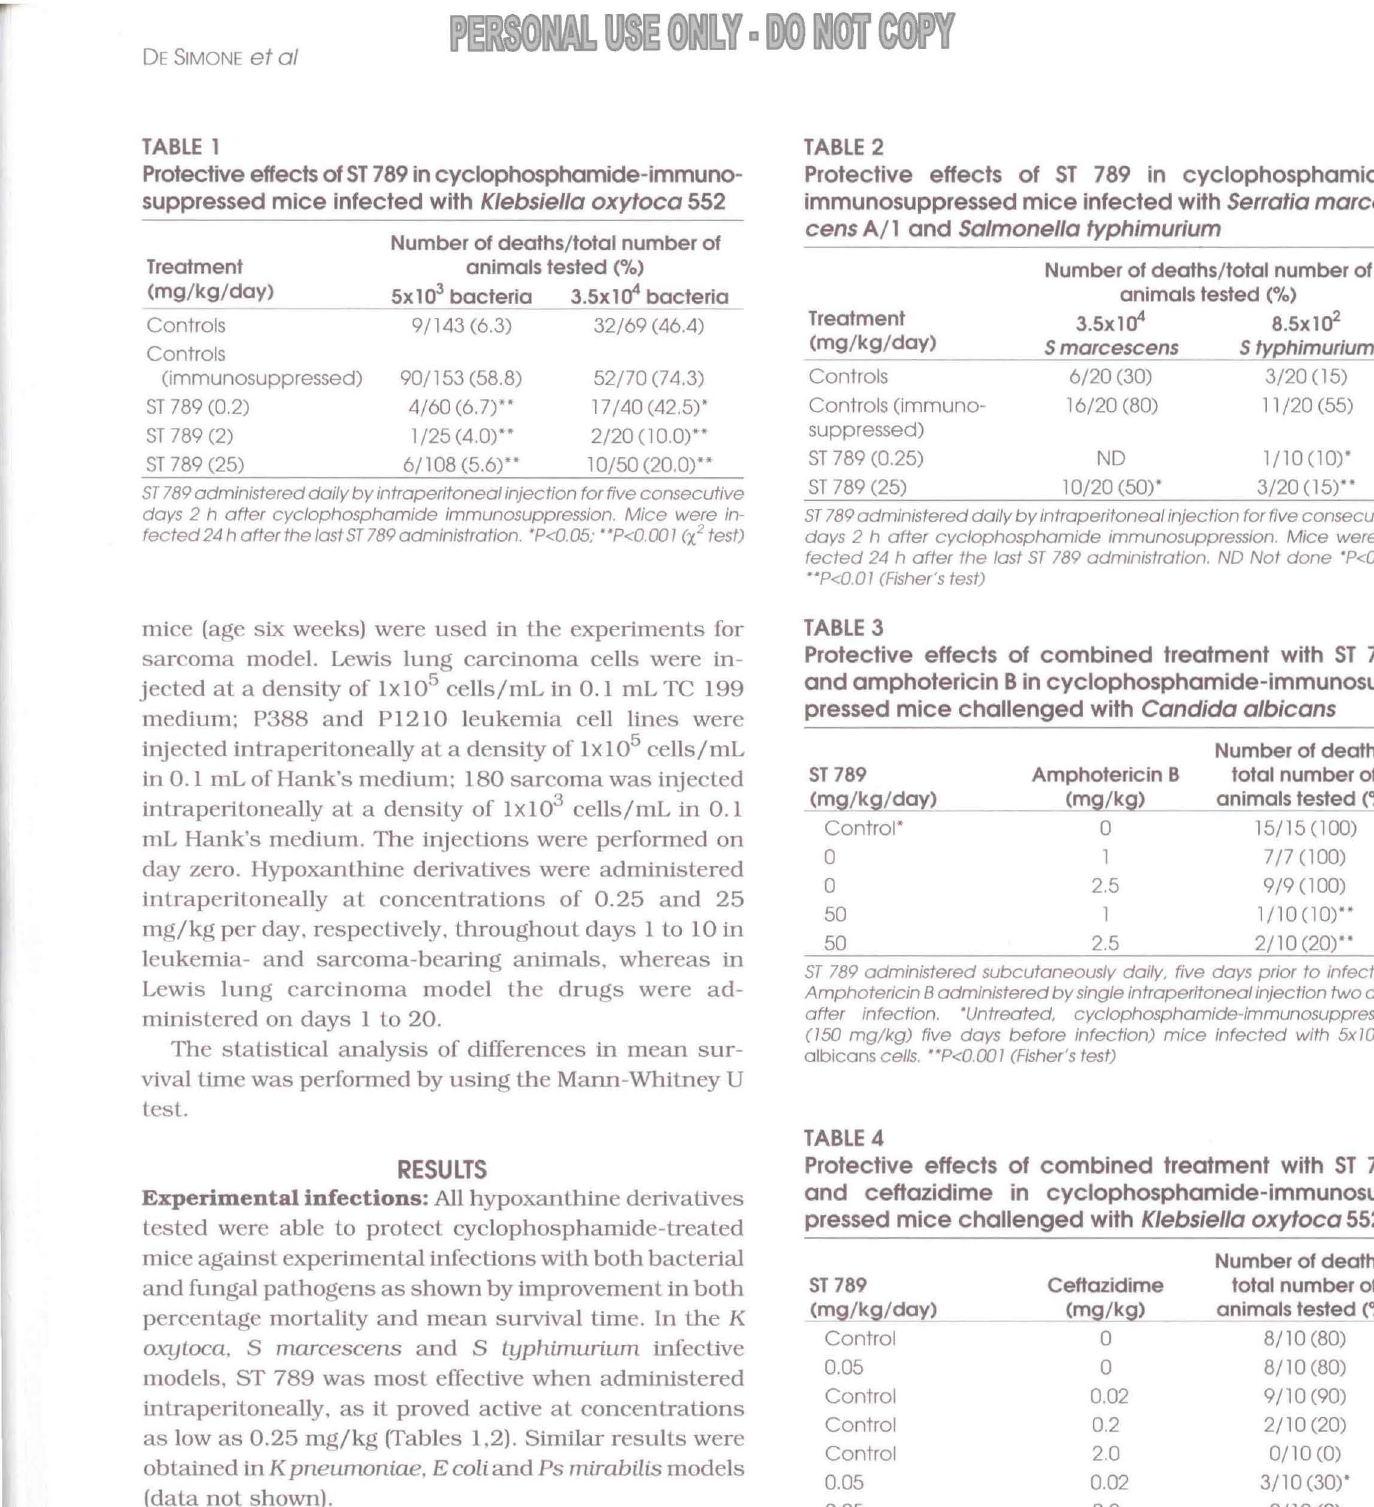
Protective effects of ST 789 in cyclophosphamide-immuno suppressed mice infected with Klebsiella oxytoca 552